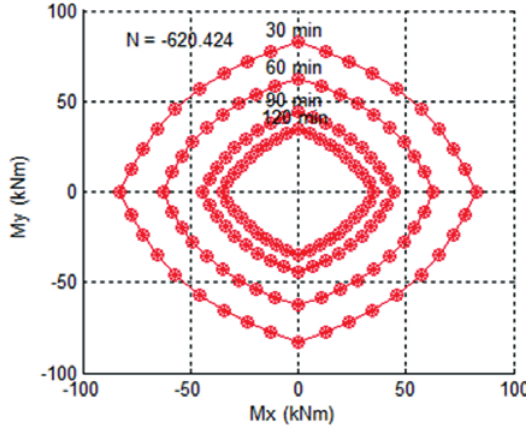
Figura 17a Curvas de interação de momentos da seção 30 cm x 30 cm com 4 ϕ 16 mm para Ns ⁄